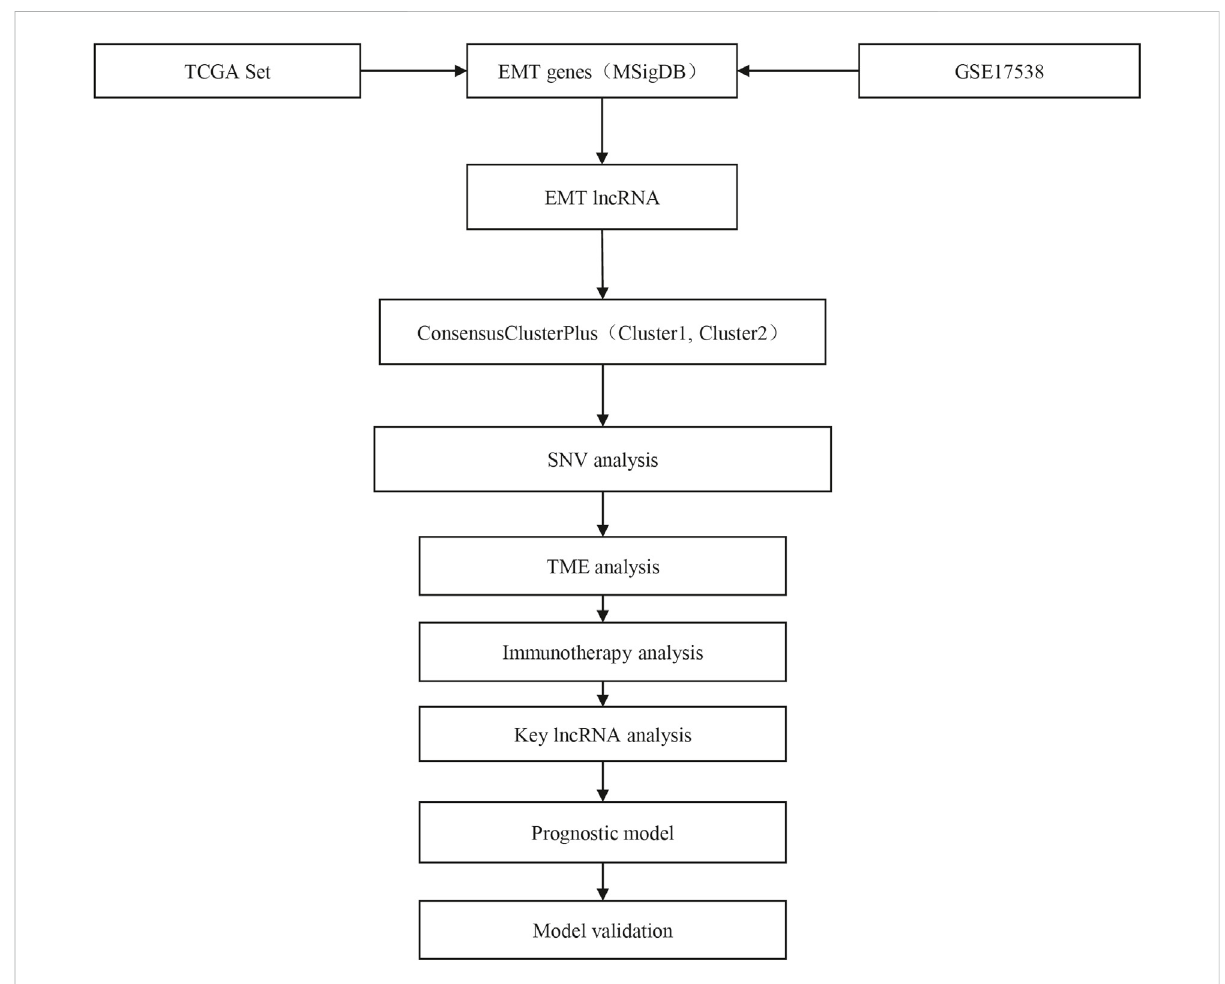
FIGURE 1 The work fl ow of this